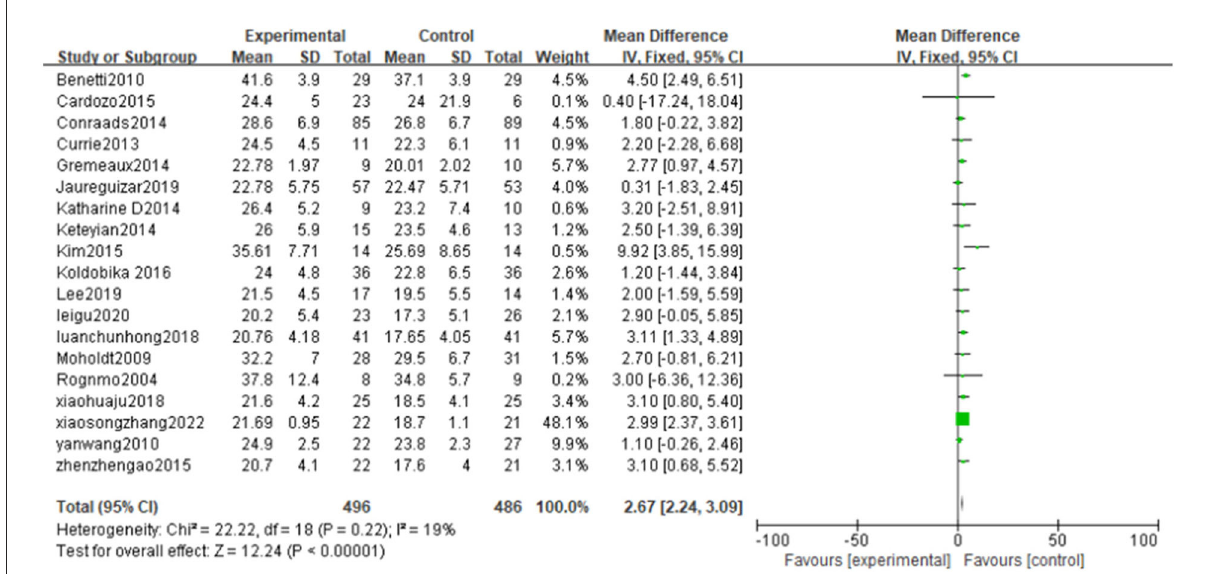
FIGURE3 Forest plot comparing the improvement of peak VO 2 between two exercise intensity.